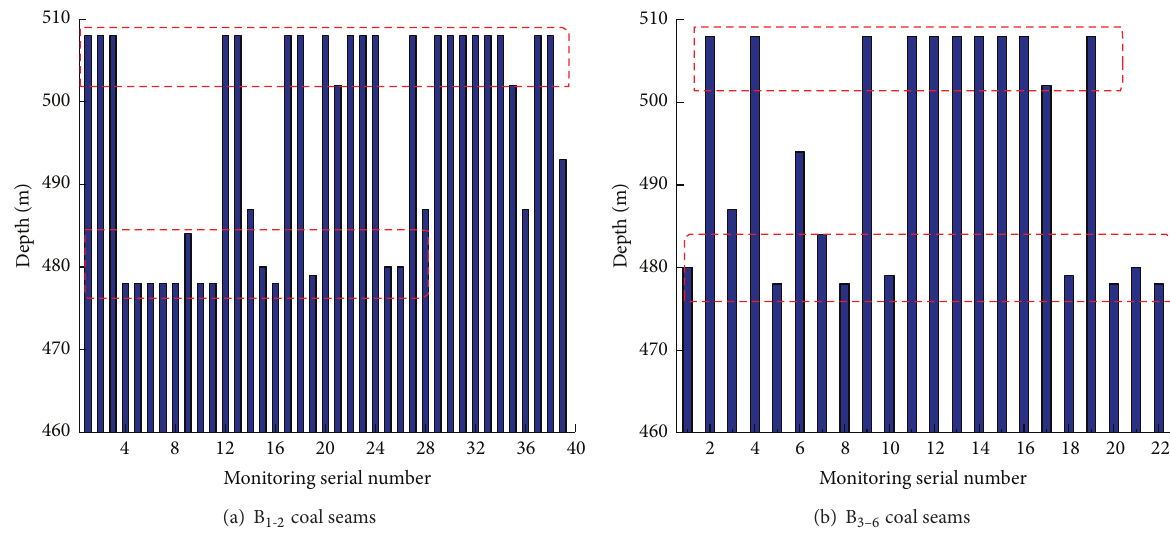
Figure 9: Distribution of mining seismicity (2013.9.8 ∼